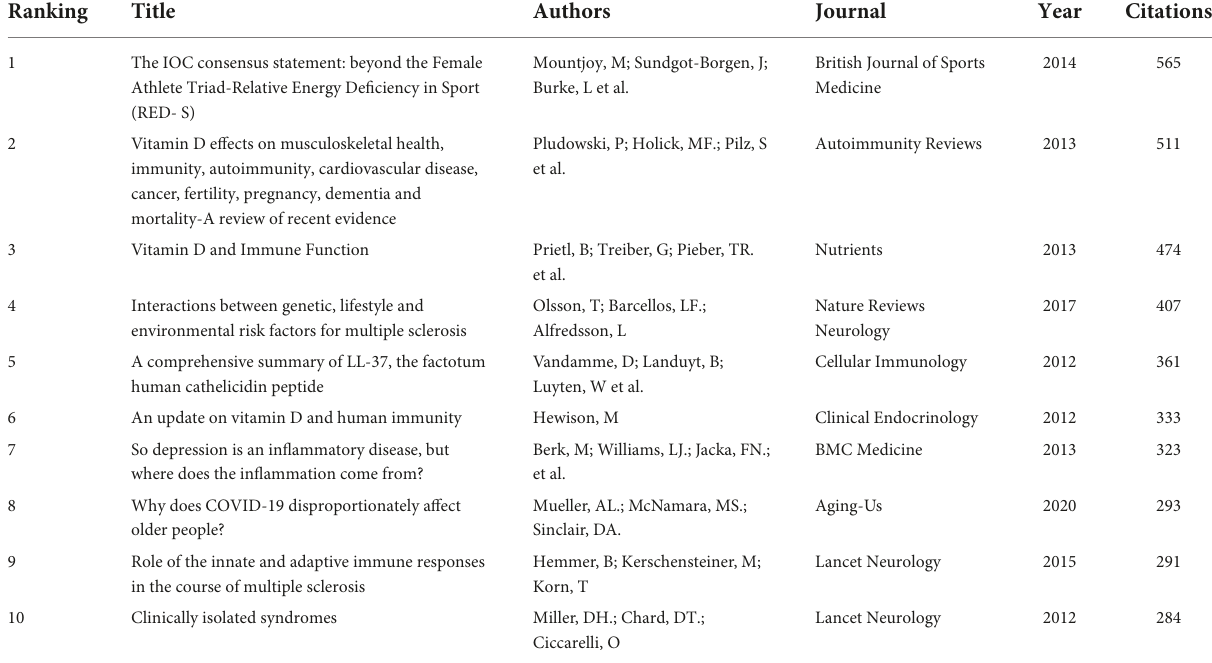
TABLE 4 Top 10 high-cited articles related to vitamin D and